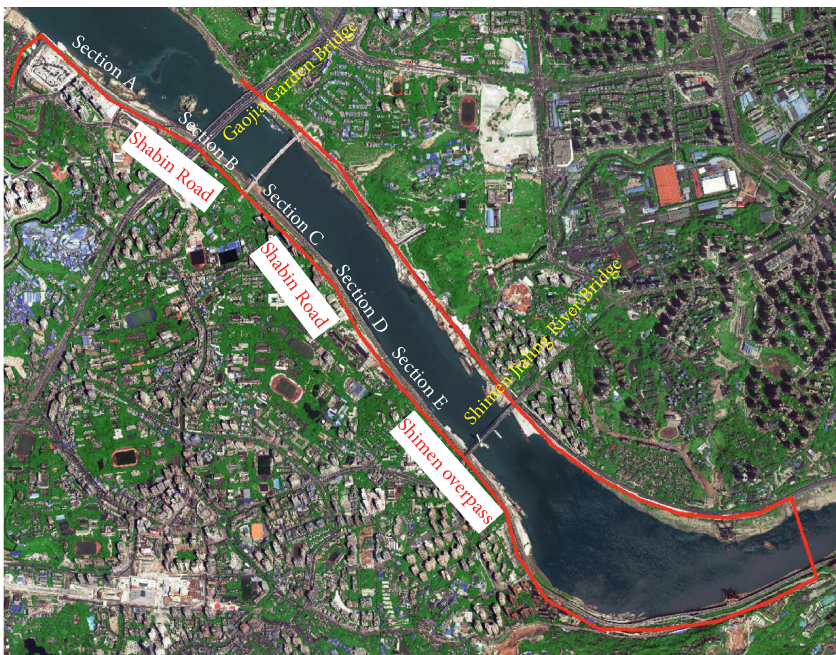
Figure 10: GIS map of the analyzed area (Shabin Road, Chongqing).